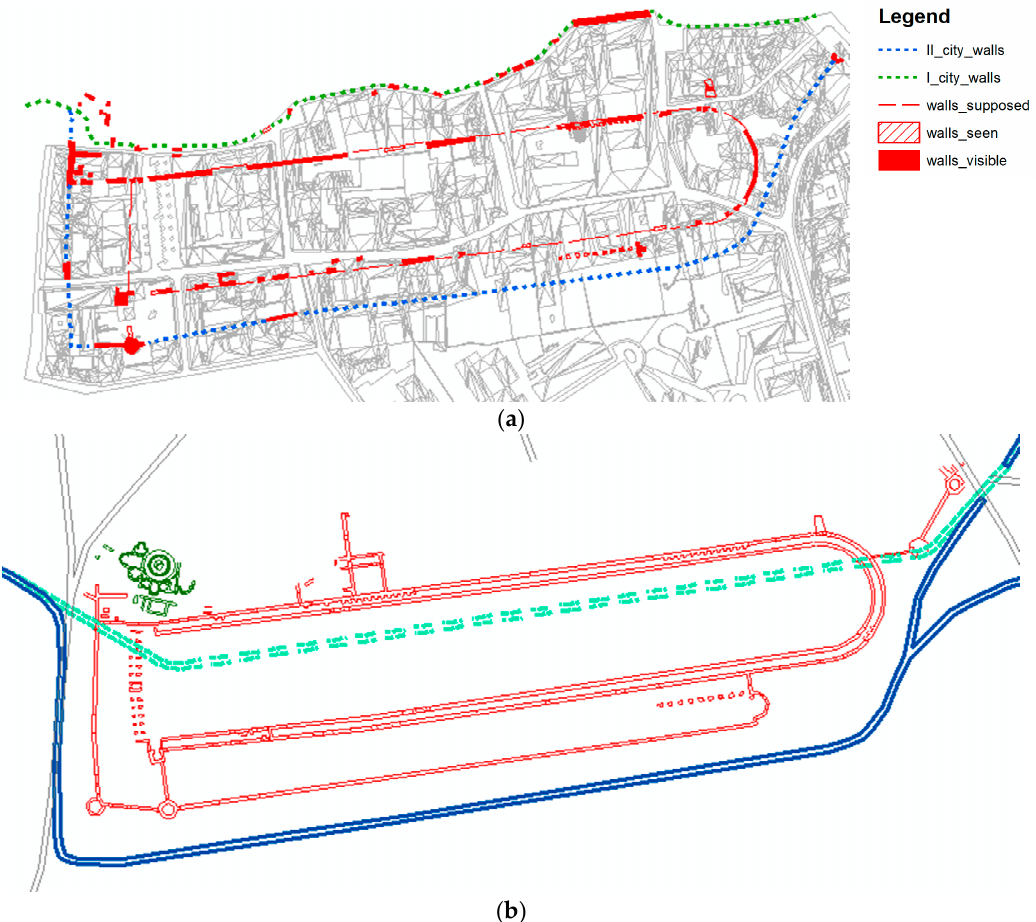
Figure 8. Georeferenced representation of the circus maps corresponding to different periods in time: ( a ) De Capitani’s map indicating various information about the walls of the circus excavated or guessed; ( b ) Mirabella Roberti’s update highlighting the different paths of the river, before (blue dashed line) and after the intervention (blue continuous line) for building the circus.